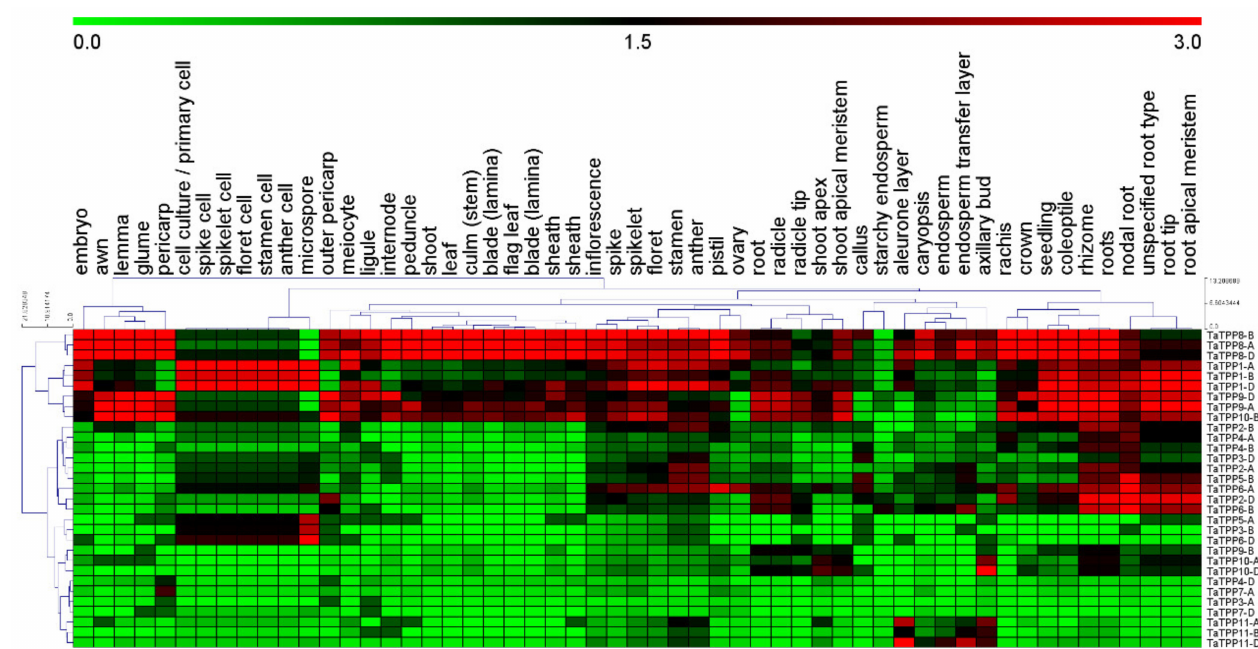
Figure 8. Transcription profiles of TaTPPs in different wheat organs. mRNA transcription data of TaTPPs in different wheat organs were retrieved from Genevestigator and presented using MeV